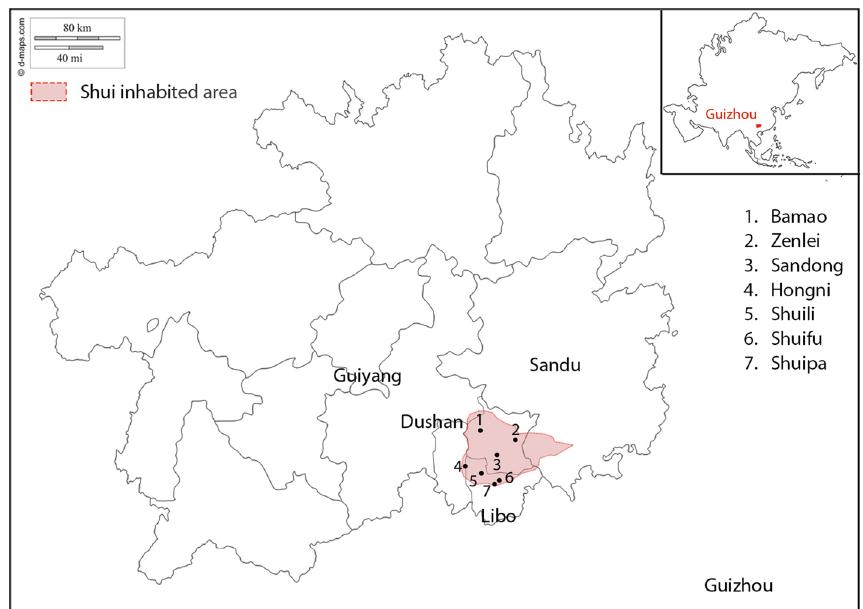
Fig. 2 Map of the area inhabited by the Shui and the case study locations (Source: base map from d-maps.com, drawn by the